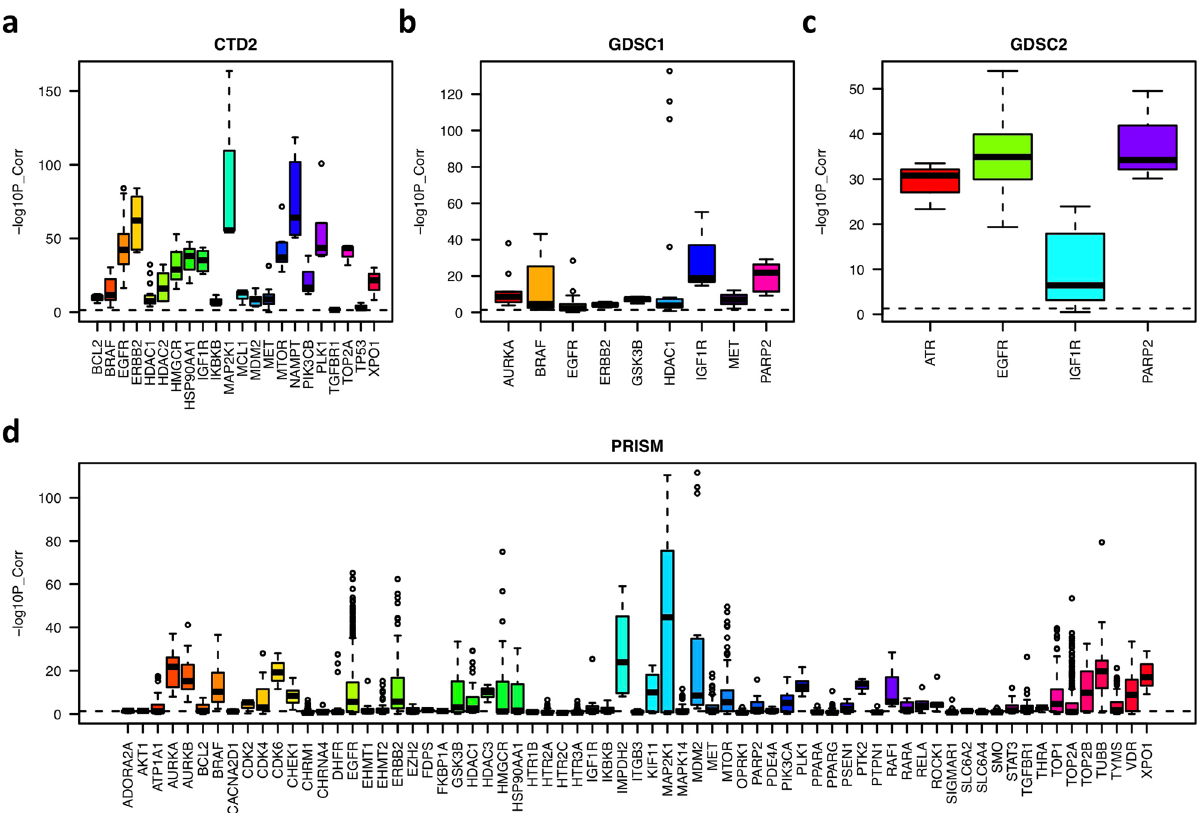
Figure 1. Boxplot of pairwise drug similarity scores targeting the same target in each data set. The similarity score is represented by the negative log10 p-value of the pairwise correlations computed based on their sensitivities across cancer cell